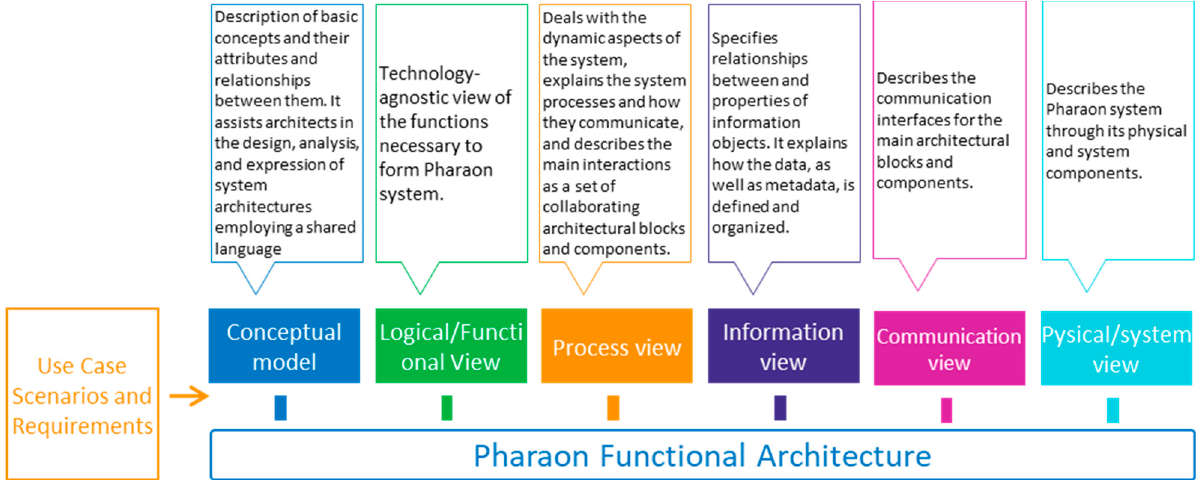
Figure 7. Pharaon architecture view model.